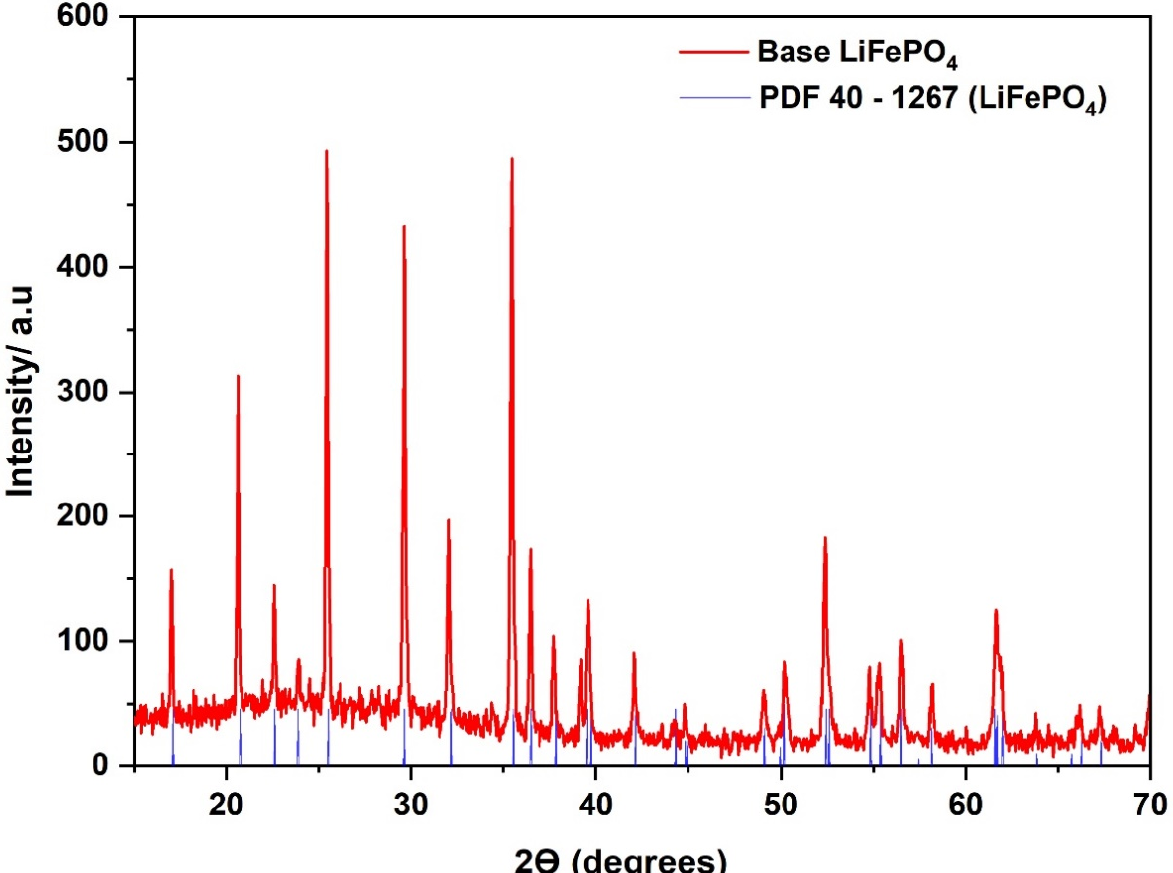
Figure 3. XRD pattern of the synthesized base LiFePO 4